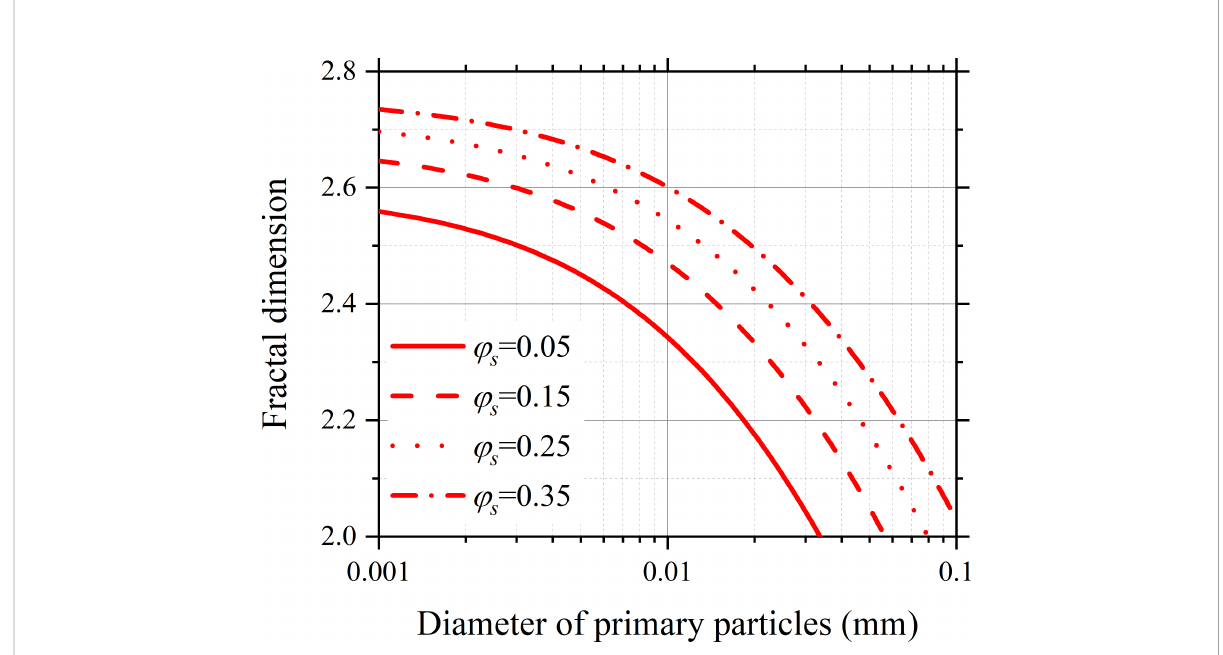
FIGURE 6 The fractal dimension varying with the diameter of primary particles and the solid volume